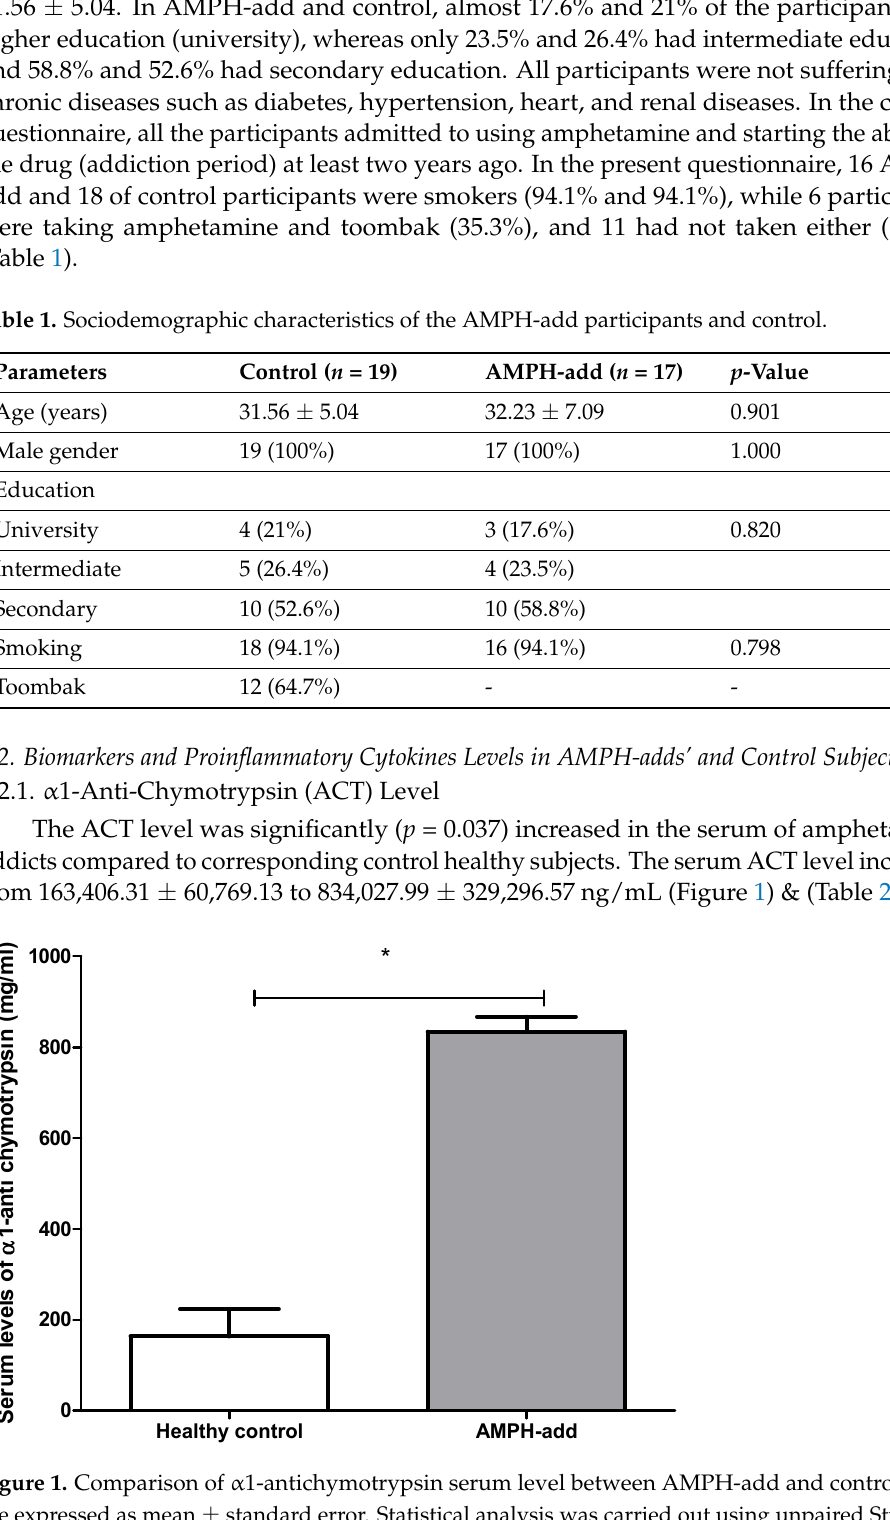
Table 1. Sociodemographic characteristics of the AMPH-add participants and control.